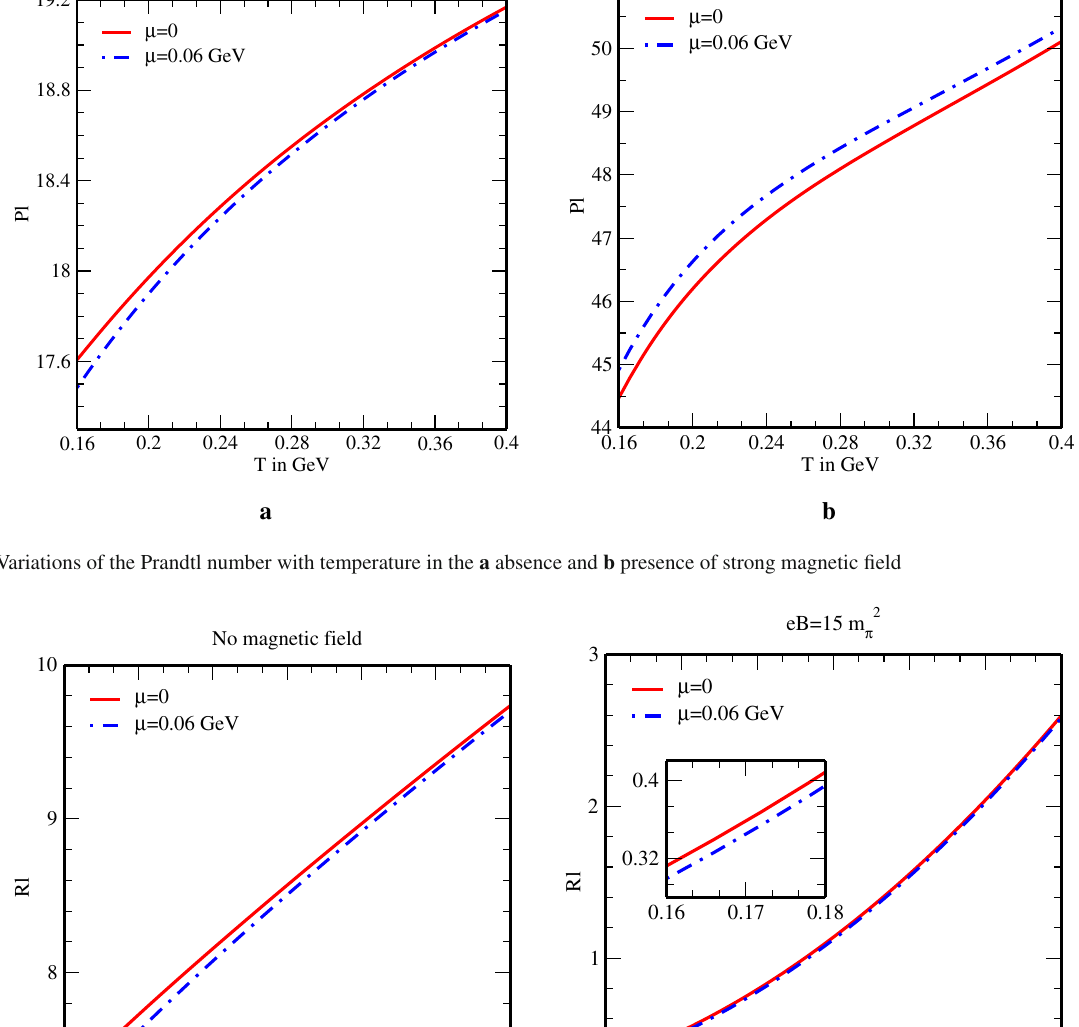
tive of pressure with respect to energy density in the bulk viscosity expression contains the magnetic field dependence, unlike that in the absence of magnetic field. As a result, η and ζ calculated in an ambience of strong magnetic field depend explicitly on magnetic field, chemical potential and tempera- ture, whereas in the absence of magnetic field, they depend on temperature and chemical potential. Therefore, in the strong magnetic field limit ( | q f B | (cid:4) T 2 ), where the energy